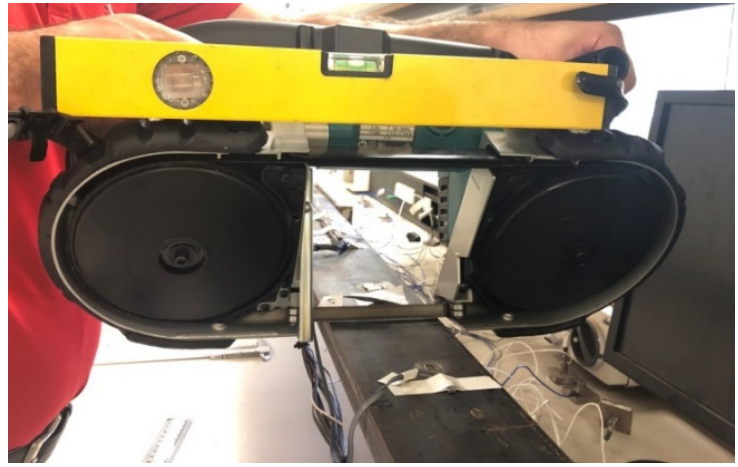
Figure 14. The band saw.